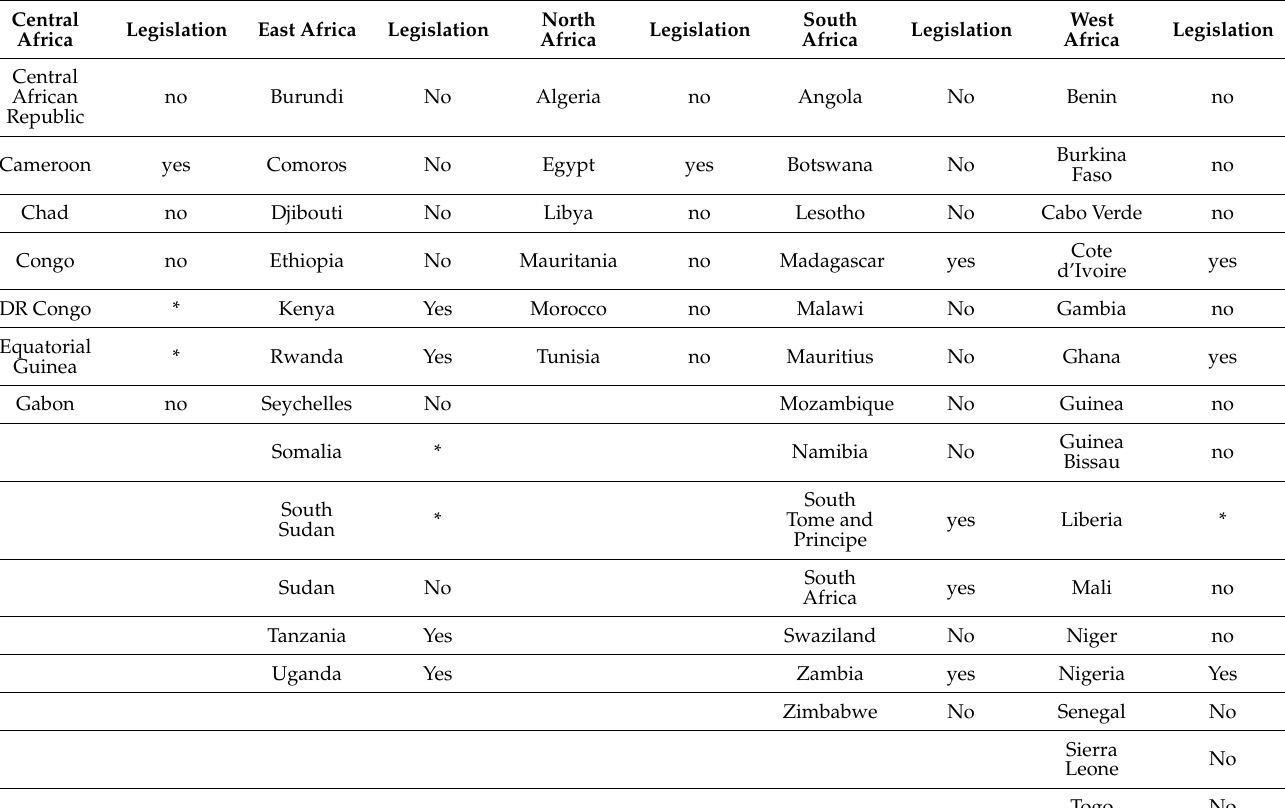
Table 2. African countries with e-waste legislation/policy